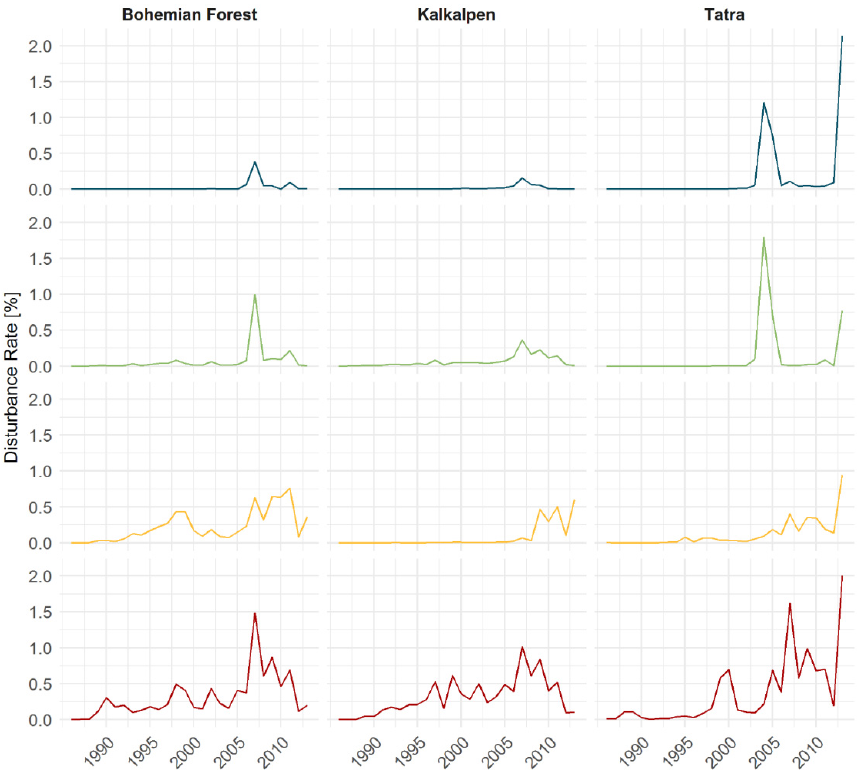
Figure 10. Annual disturbance rates for the four disturbance agent classes at the study